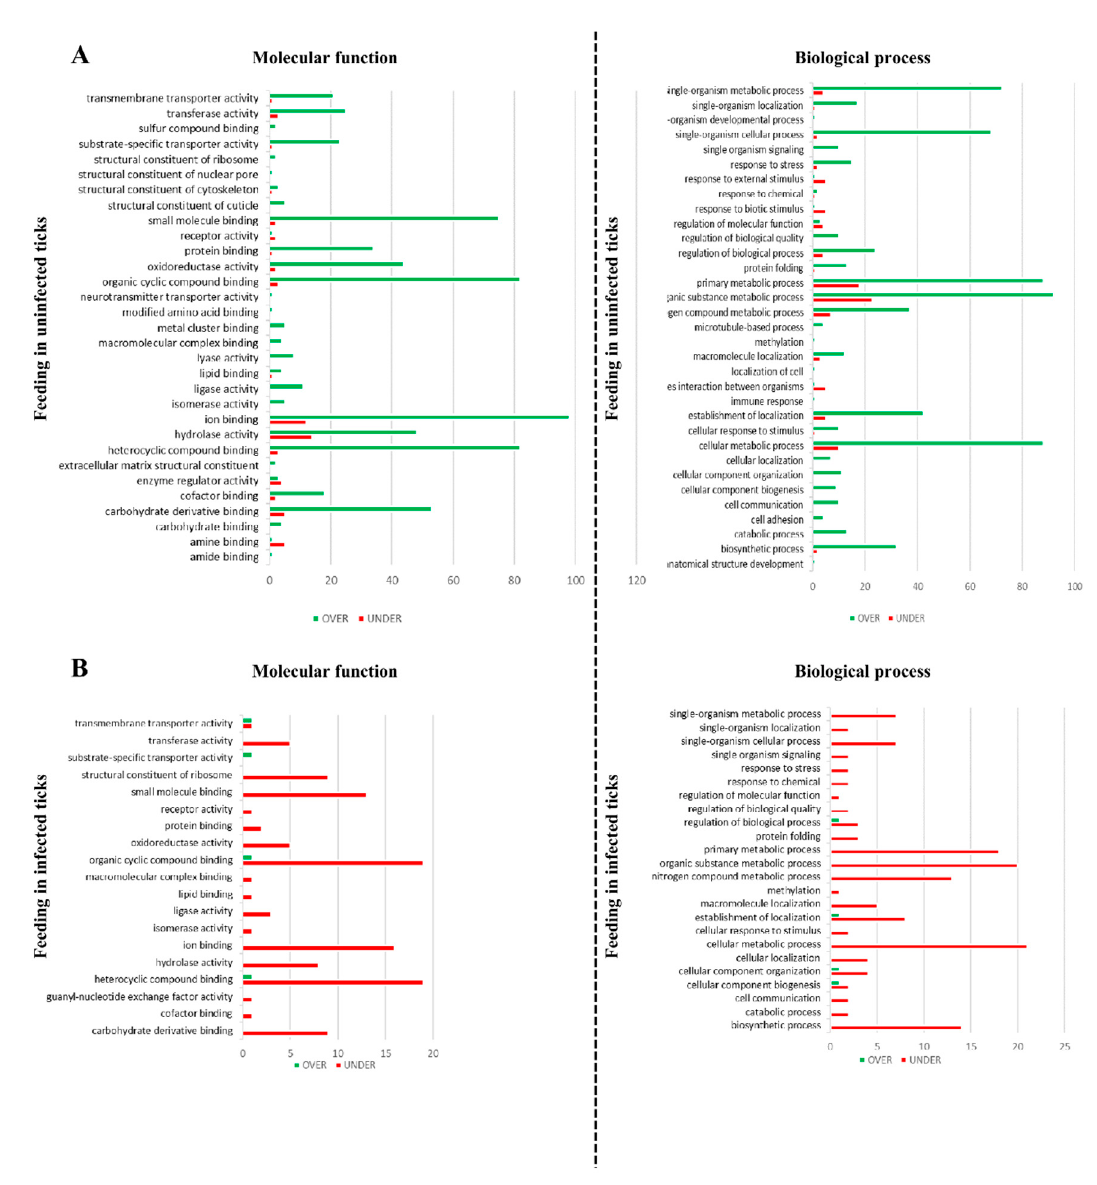
Figure 4. Gene ontology of the effect of feeding in uninfected ( A ) and B. ovis infected ( B ) R. bursa ticks. Functional terms at level 3 were assigned based on UniProt and associated databases. Green bars = over-represented proteins, red bars = under-represented proteins.